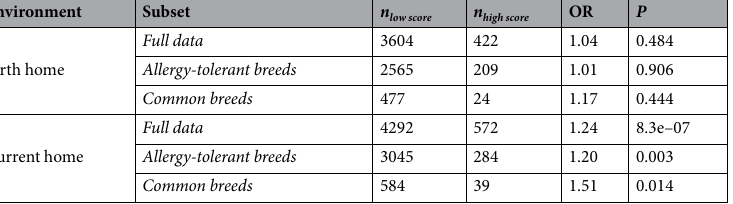
Table 1. Logistic regression on the risk of high allergy score (based on owner-reported allergic symptoms) against environmental land-use around the dog’s home at birth and the current home in all subsets. When current living environment becomes more urban, odds to become allergic are higher. Odds Ratio, OR = exp(estimate).